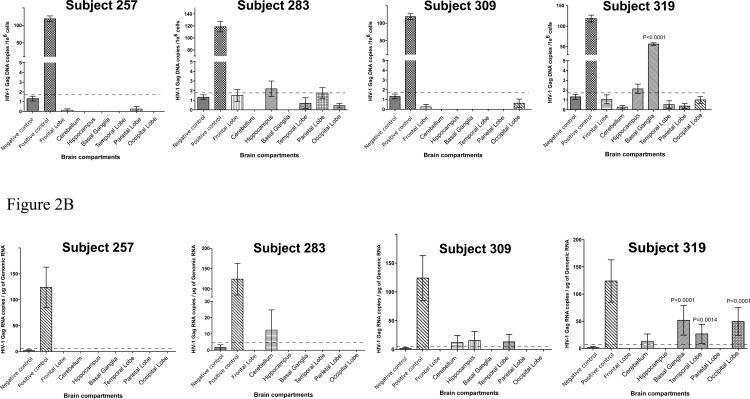
Droplet digital PCR detection of HIV-1 DNA and RNA in brain tissues of ART failure individuals.(A) HIV-1 gag DNA copies per million cells in various brain tissues (B) HIV-1 gag RNA copies per million cells in various brain tissues. P-value indicate statistically significant from background/negative control. Dash lines indicate cut-off value for ddPCR positivity based on the negative control. Negative control derived from brain tissue of a HIV-1 negative individual. Positive control derived from brain tissue of a HIV-1 positive but ART naïve individual.